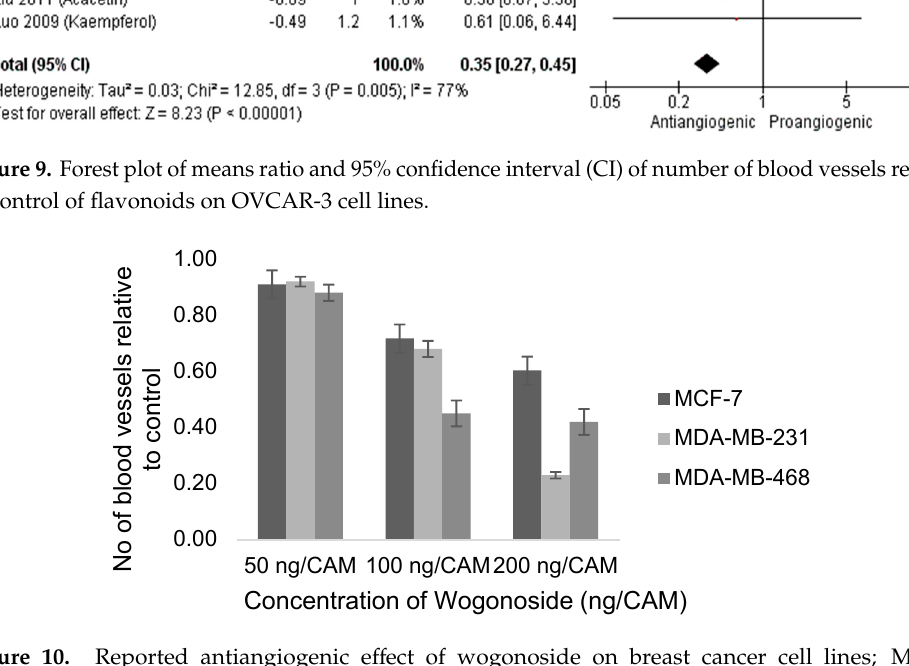
Figure 10. Reported antiangiogenic effect of wogonoside on breast cancer cell lines; MCF-7, MDA-MB-231 and MDA-MB-468 ± SEM.